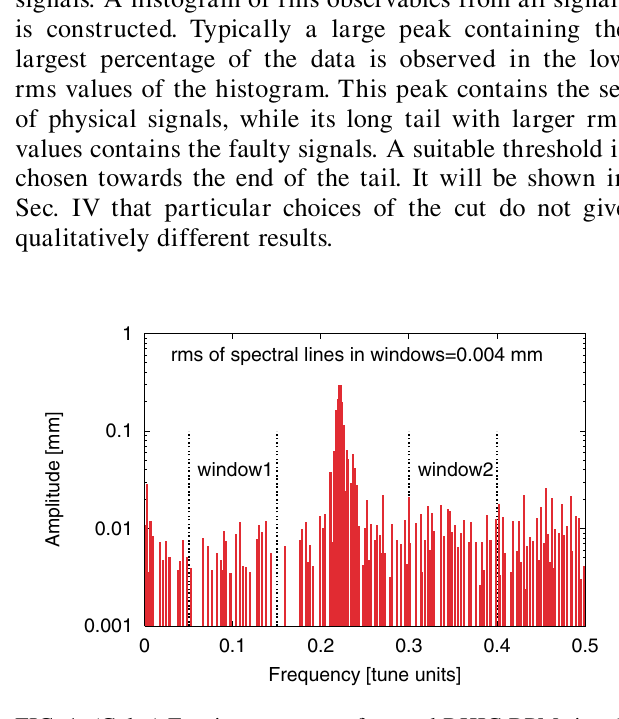
FIG. 1. (Color) Fourier spectrum of a good RHIC BPM signal. The spectral lines within the windows are used to determine the rms noise